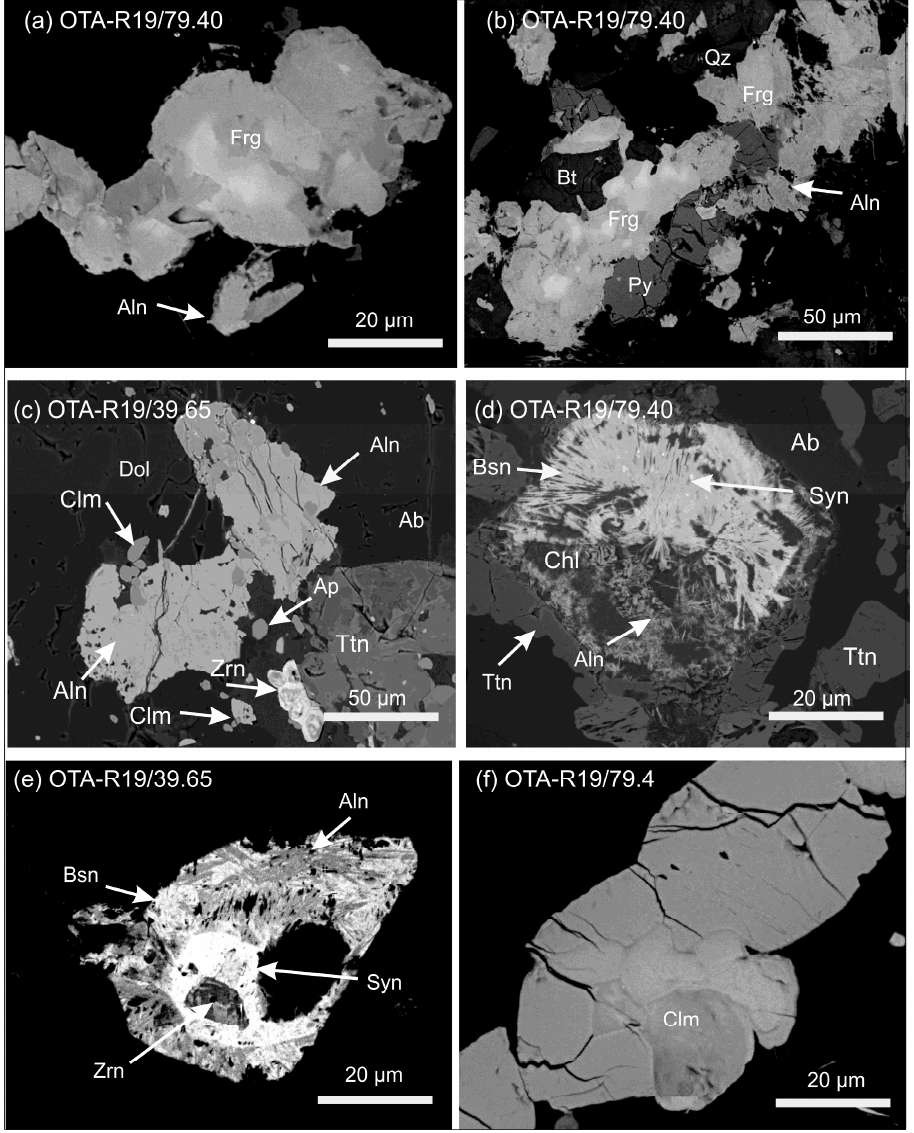
Figure 9. Back-scattered electron images REE-bearing minerals in Otanmäki alkaline granitic samples; ( a , b ) Fergusonite (Frg) in association with allanite (Aln), biotite (Bt) and pyrite (Py), fergusonite shows mostly patchy zoning with the brightest areas having high U and Th; ( c ) Primary magmatic allanite (Aln) associated with albite (Ab), biotite (Bt), quartz (Qz), zircon (Zrn), columbite (Clm), apatite (Ap) and titanite (Ttn); ( d , e ) Aggregates of thin platy crystals of REE carbonate minerals, mainly synchysite (Syn) and bastnäsite (Bsn) in association with allanite (Aln) and chlorite (Chl); ( f ) Columbite (Clm) as elongate to subhedral shows simple core-rim zoning with U content.